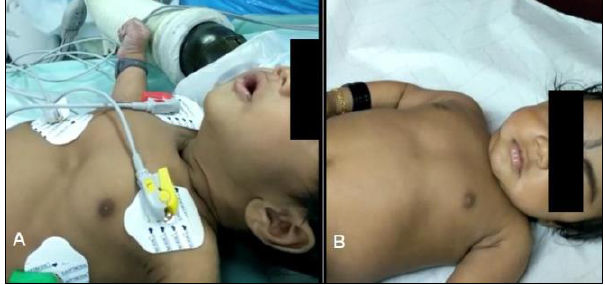
Figure 1: A) Preoperative picture of 45-day old baby with chest in-drawing, subcostal retractions and audible stridor. B)